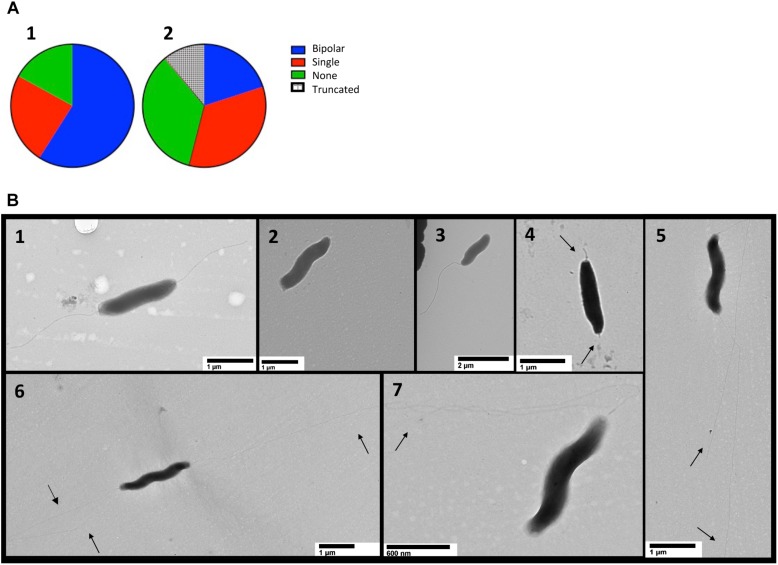
TEM detects flagellar differences in cjridA mutants. TEM was used to visualize the flagella of wild type and two cjridA mutants on multiple days. One hundred cells with clearly visible poles were assessed in each mutant or wild type. Pie charts in (A) represent the distribution of bipolar flagella (blue), a single polar flagellum (red) no flagellum (green) and truncated flagella (hatched). For wild type, N = 100, for cjridA, N = 200 (with 100 from each of two independent mutants) and long and thin flagella (quantified as bipolar or single) were classified by number of flagellar filaments. Lower panels (B1–B7) show representative TEM images for cells with: (B1) bipolar flagella, wild type is represented: (B2) no flagellum, cjridA mutant is represented; (B3) a single polar flagellum,cjridA mutant is represented; (B4) truncated flagella, seen only in cjridA mutants; and (B5–B7) long, potentially thin flagella, seen only in cjridA mutant.